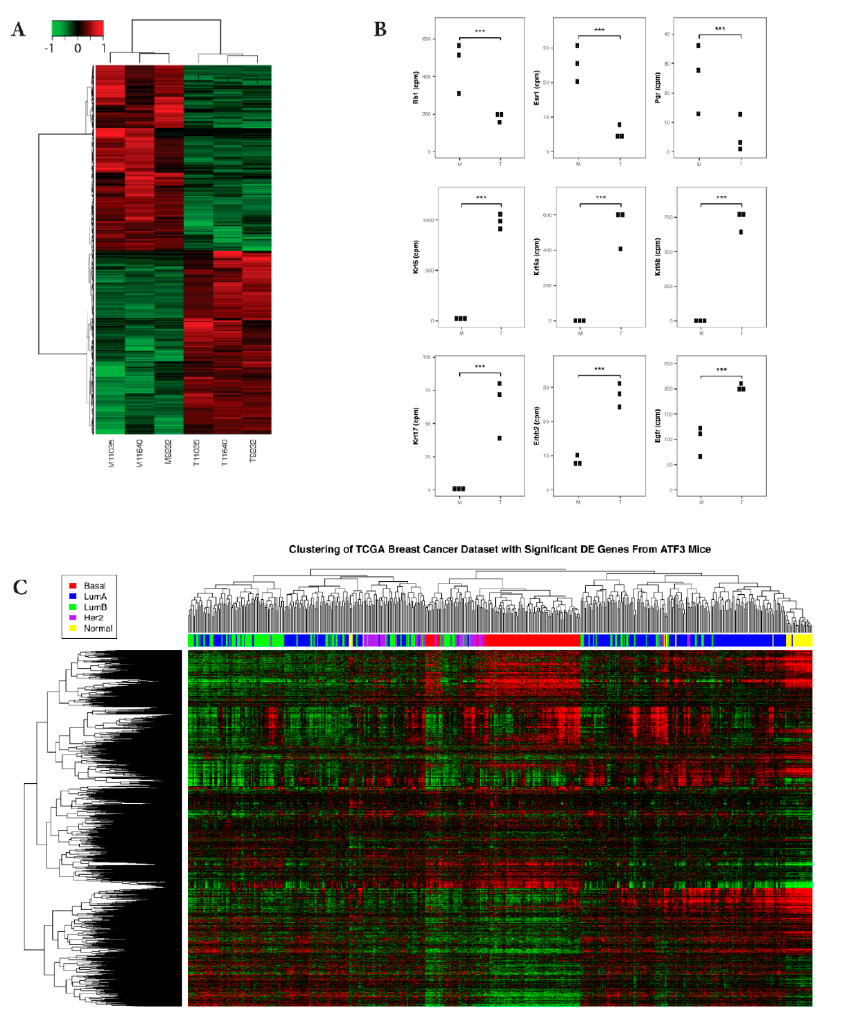
Figure 1. Gene expression patterns of ATF3-induced tumors are consistent with those of human basal-like breast cancer (BLBC). ( A ) Unsupervised hierarchical clustering and heatmap presentation of all DEGs were generated from three pairs of matched, adjacent, normal mammary glands (M) and mammary tumors (T) from BK5.ATF3 transgenic mice using the hclust and heatmap2 functions in R with gene expression values calculated using edgeR. Red represents upregulated genes and green represents downregulated genes. The expression values are log2 fold changes between tumor and adjacent normal tissues (fold change ≥ 2.0, FDR ≤ 0.05). ( B ) Dot plots showing the difference in expression of selected genes in BK5.ATF3 mice for both normal tissue (M) and tumor tissue (T). *** indicates a significance of FDR < 0.005. ( C ) Unsupervised hierarchical clustering and heatmap presentation comparing expression of 3979 differentially expressed genes (DEGs) identified in the BK5.ATF3 mammary tumors and their human homologs. The expression profiles for the 3979 genes in 547 human breast cancer samples representing Basal-like, LuminalA, Luminal B, Her2, and Normal- like subtypes were compared with the mouse DEGs. The colored bar across the top indicates the subtypes of the patient samples depicted in the figure key: Basal-like (red), LumA (blue), LumB (green), Her2 (purple), and Normal (yellow). The horizontal dendogram on the top represents the 547 patient samples, and the vertical dendogram on the left represents 3979